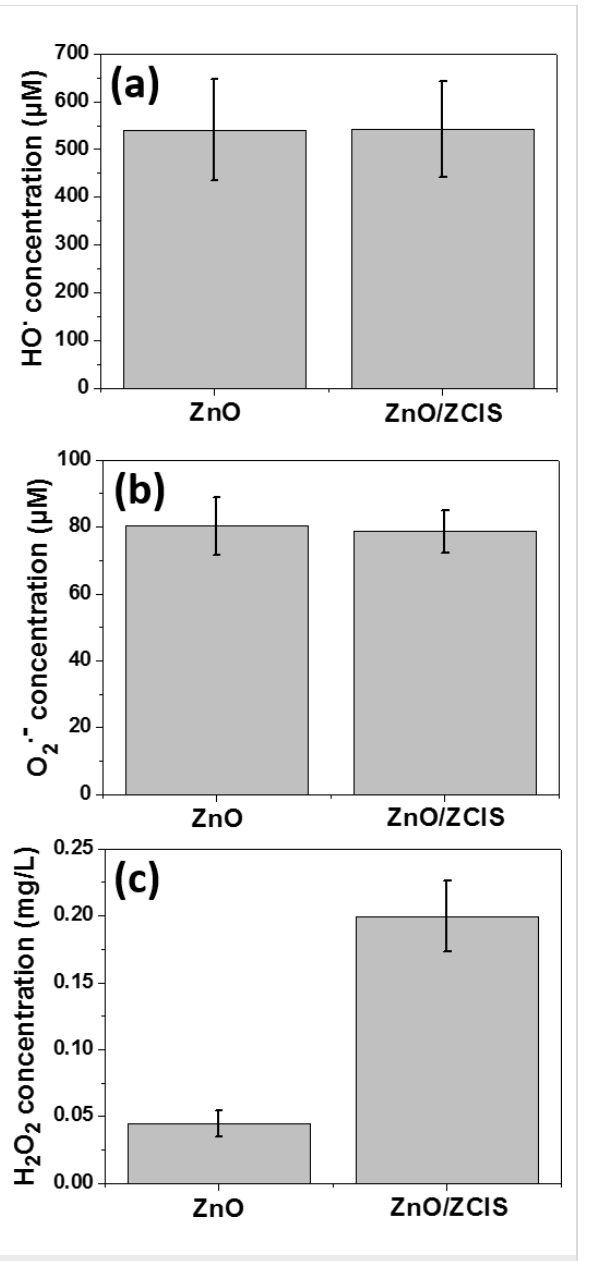
Figure 9: Concentration of (a) hydroxyl and (b) superoxide radicals and (c) hydrogen peroxide produced by ZnO and ZnO/ZCIS particles under irradiation using a Hg–Xe lamp. Concentrations of hydroxyl and superoxide radicals and hydrogen peroxide were determined after 30 min, 1 h and 45 min irradiation, respectively.